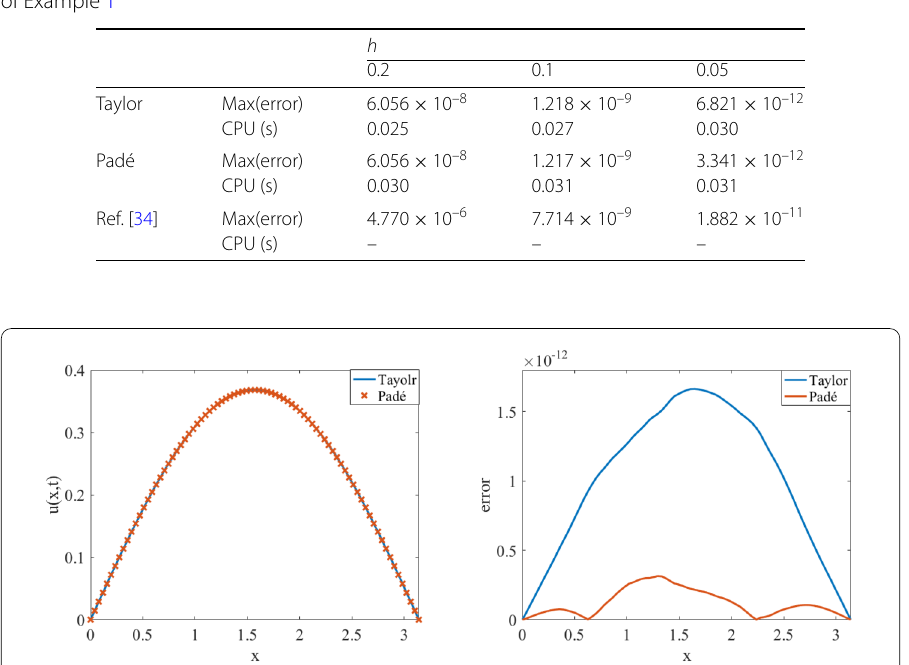
Table 4 Numerical results of CFDS-PIM ( τ = 1 × 10 –4 ) and Ref. [34] ( τ = 1 × 10 –6 ) at t = 1 for case 3 of Example 1